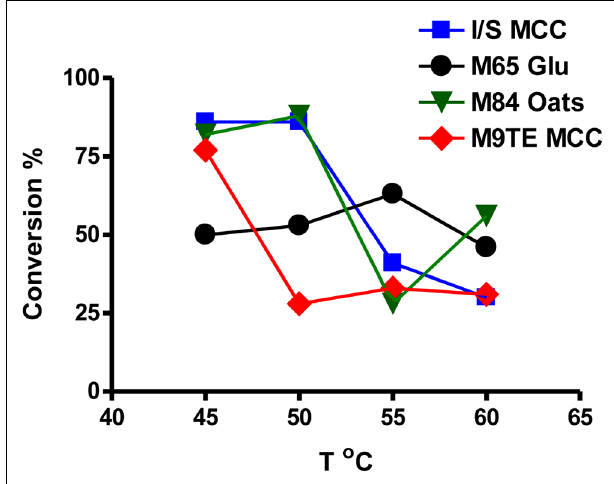
FIGURE 3 | Direct comparison of supernatants from cell cultures grown in media containing the recommended energy source after 24 h. Squares, I/S + 1% MCC; circles, Medium 65 + 10 mM glucose; triangles, Medium 84 + rolled oats; diamonds, M9TE + 1% MCC.